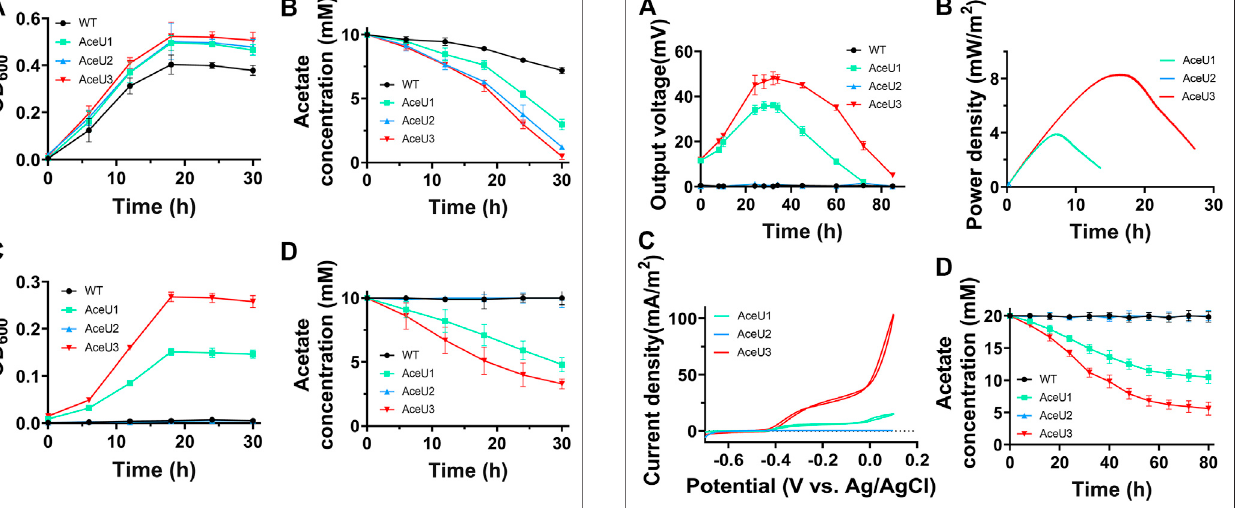
Supplementary Figure S1 . Expression level of mRNA in each of these strains was quanti fi ed by real-time PCR (RT-PCR). Under the conditions of adding 0.75 mM IPTG as inducer, the transcriptional expression levels of ato1 , ato2 and gltA were 5.0, 4.1 and 5.1 folds higher than the normalization gene, respectively ( Supplementary Figure S2 ). This result indicated that the three target genes could be well expressed in AceUs.